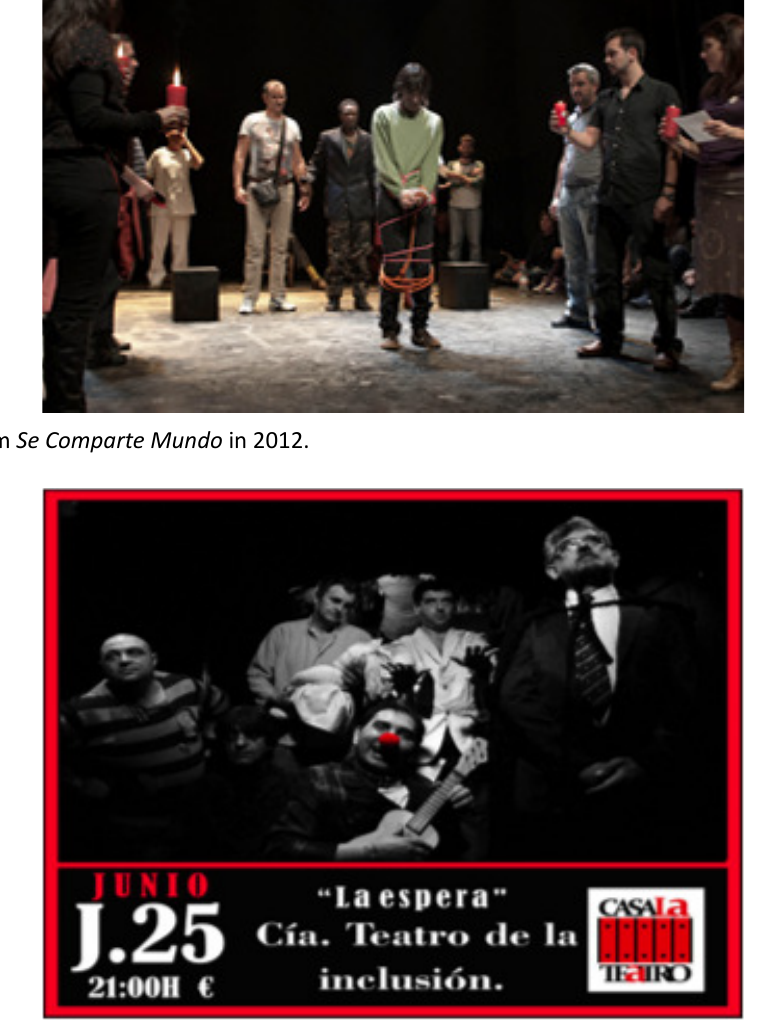
Figure 4. A poster announcing the premiere of La Espera at a theatre in Seville. many individuals who are not represented by any parlia‐ ment or government